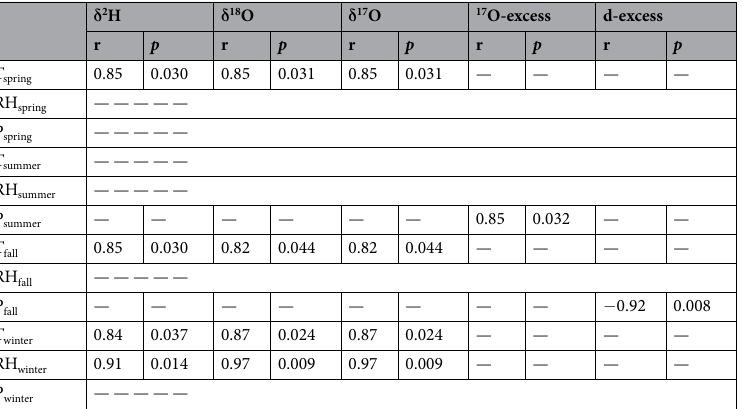
— — — — — Table 4. The relationships between the monthly precipitation isotopes ( δ 2 H/ δ 18 O/ δ 17 O), 17 O-excess, d-excess and local meteorological parameters (temperature (T), relative humidity (RH) and precipitation amount (P)) within different seasons. “ − ” indicates the insignificant